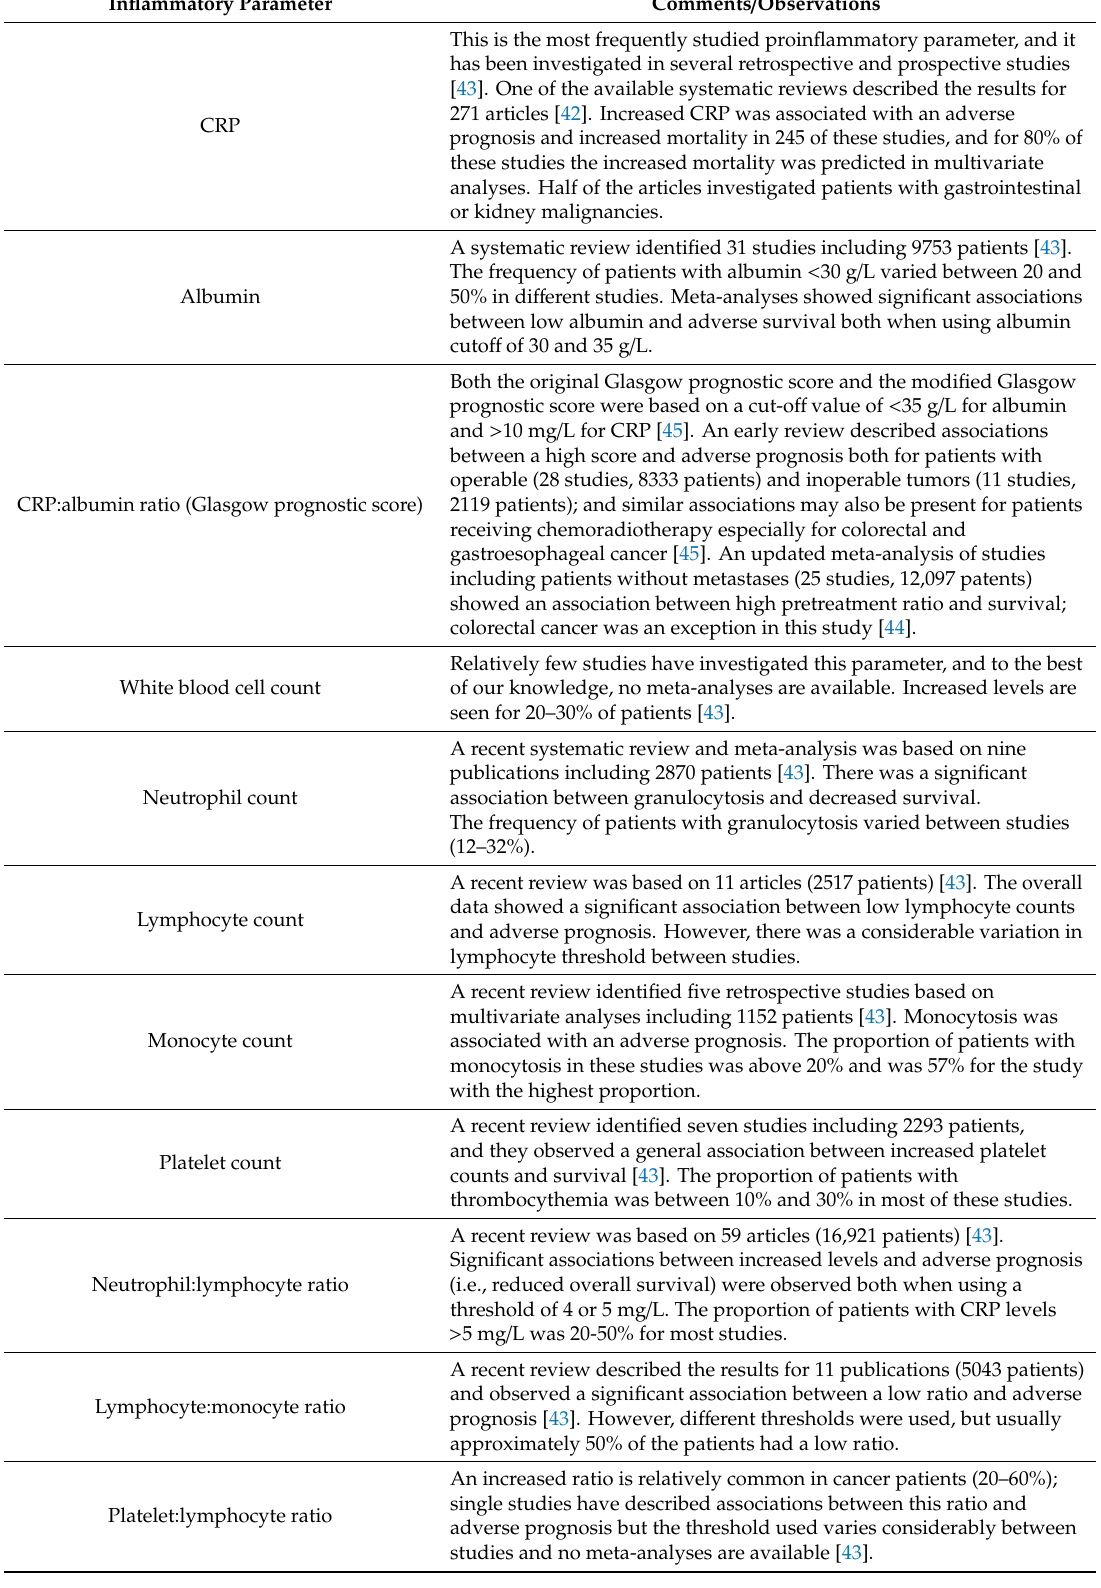
Table 3. Markers of proinflammatory activity investigated as possible prognostic parameters in cancer patients [42–45]. The table summarizes observations from meta-analyses of the various proinflammatory markers investigated in various malignancies (mainly solid